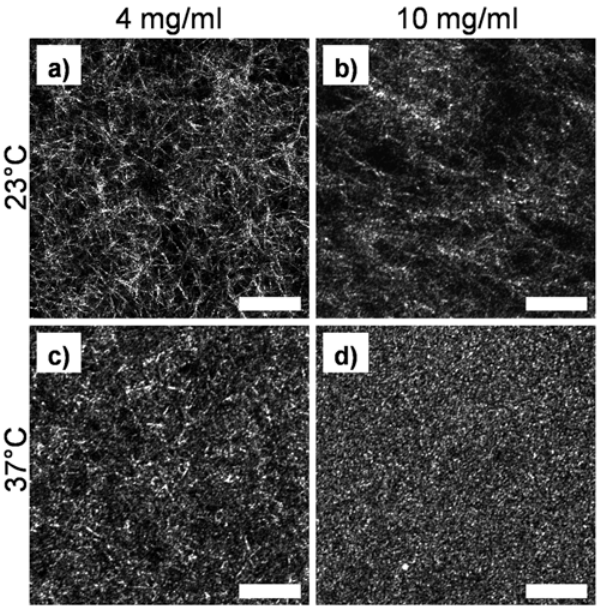
Fig 6. Fiber structure images obtained from confocal reflectance. Images shown are for hydrogels polymerized at pH 7.4. Scale bar 25 μ m.